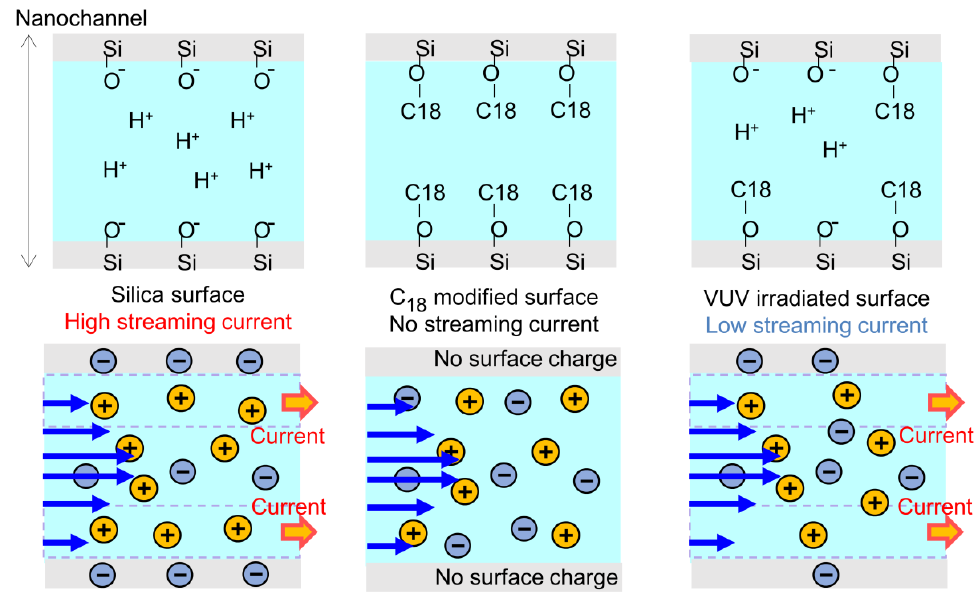
Figure 2. Principle of streaming current corresponding to surface charge.